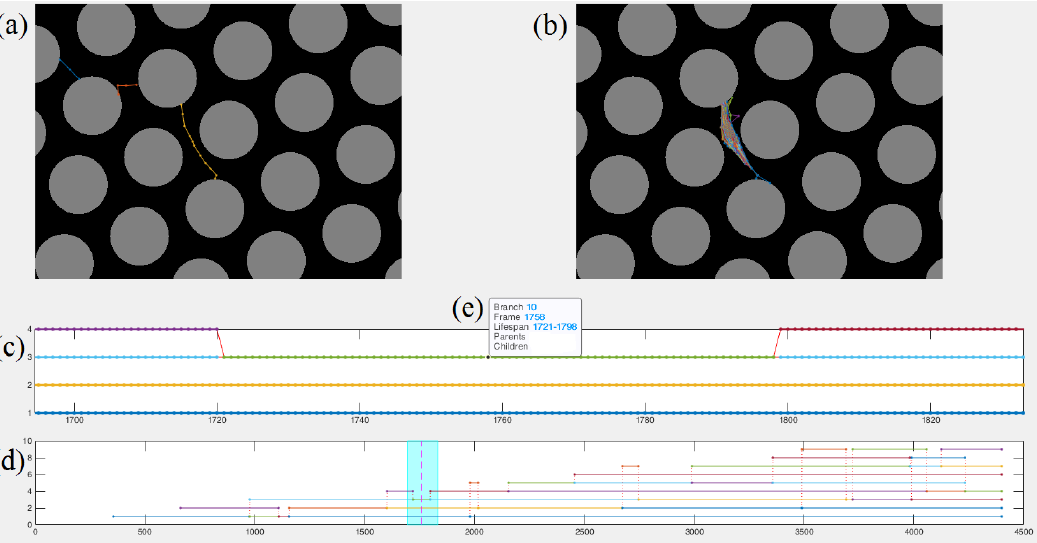
Figure 6. Screenshot of an interactive evolution chart for the 150mbar experiment showing ( a ) dis- placement fronts in frame 1758, ( b ) displacement fronts collected by evolution branch 10, ( c ) a magnifiable, scrollable detailed evolution time line, ( d ) a clickable overview time line of the first 4400 frames, and ( e ) a custom datatip showing the branch number, frame number, branch lifespan, and parent (data from [4,9]) and children (data from [11,12]) branch numbers.